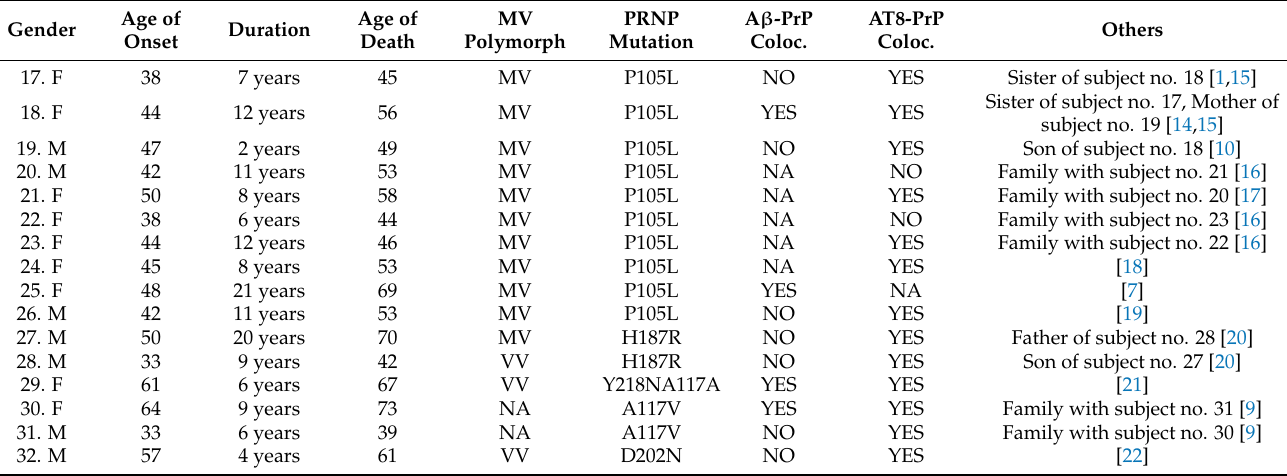
Table 3. Summary of cases found in the literature having mutations other than P102L in the PRNP gene with information on amyloid-beta and hyperphosphorylated tau protein colocalization with pathological prion protein. (Explanatory note: NA—not available;